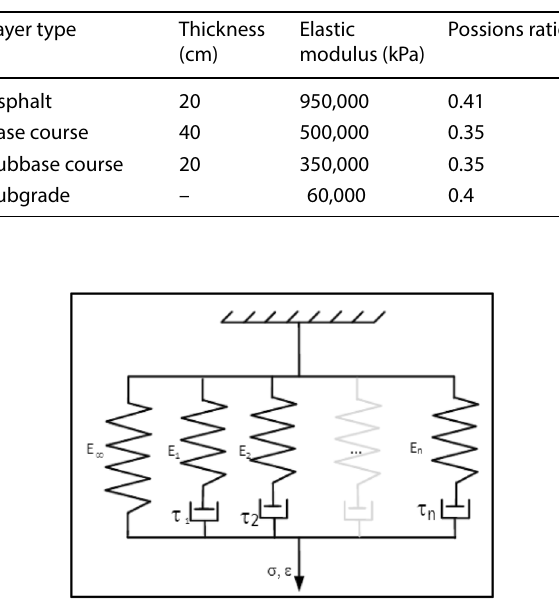
Fig. 3 Illustration of a generalized Maxwell